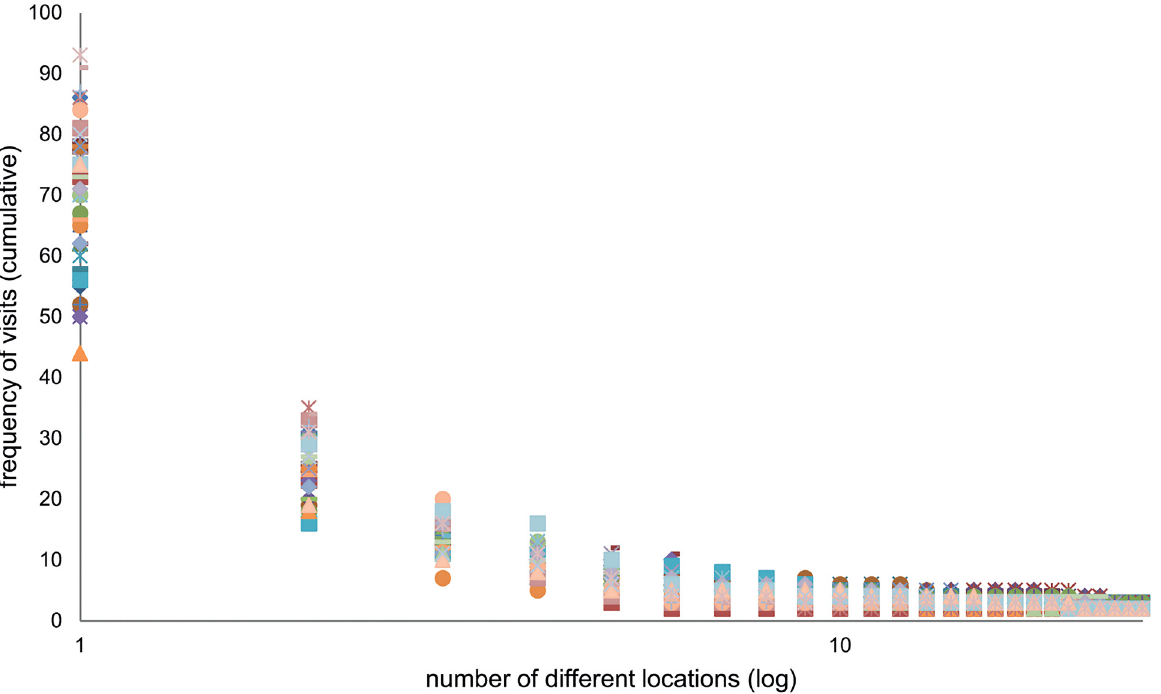
Fig 4. Cumulative frequency of visits to specific locations for 50 randomly selected agents on semi-log scales. Note that despite the qualitative similarity of the different agents ’ behavior, there are quantitative differences among